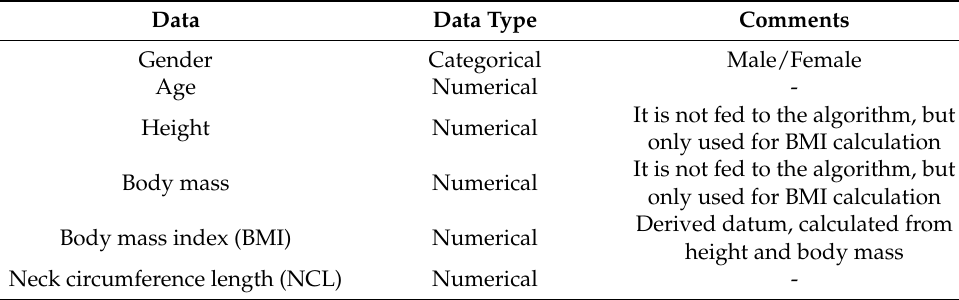
Figure 1. Flowchart of the Intelligent Clinical Decision Support System, showing how the information progresses through three stages. In Stage 1, the initial information is collected and pre-processed. In Stage 2, the processing of the collected information is carried out, and finally, in Stage 3, a recommendation regarding the patient’s diagnosis is provided. Table 2. Information related to general and anthropometric data of the